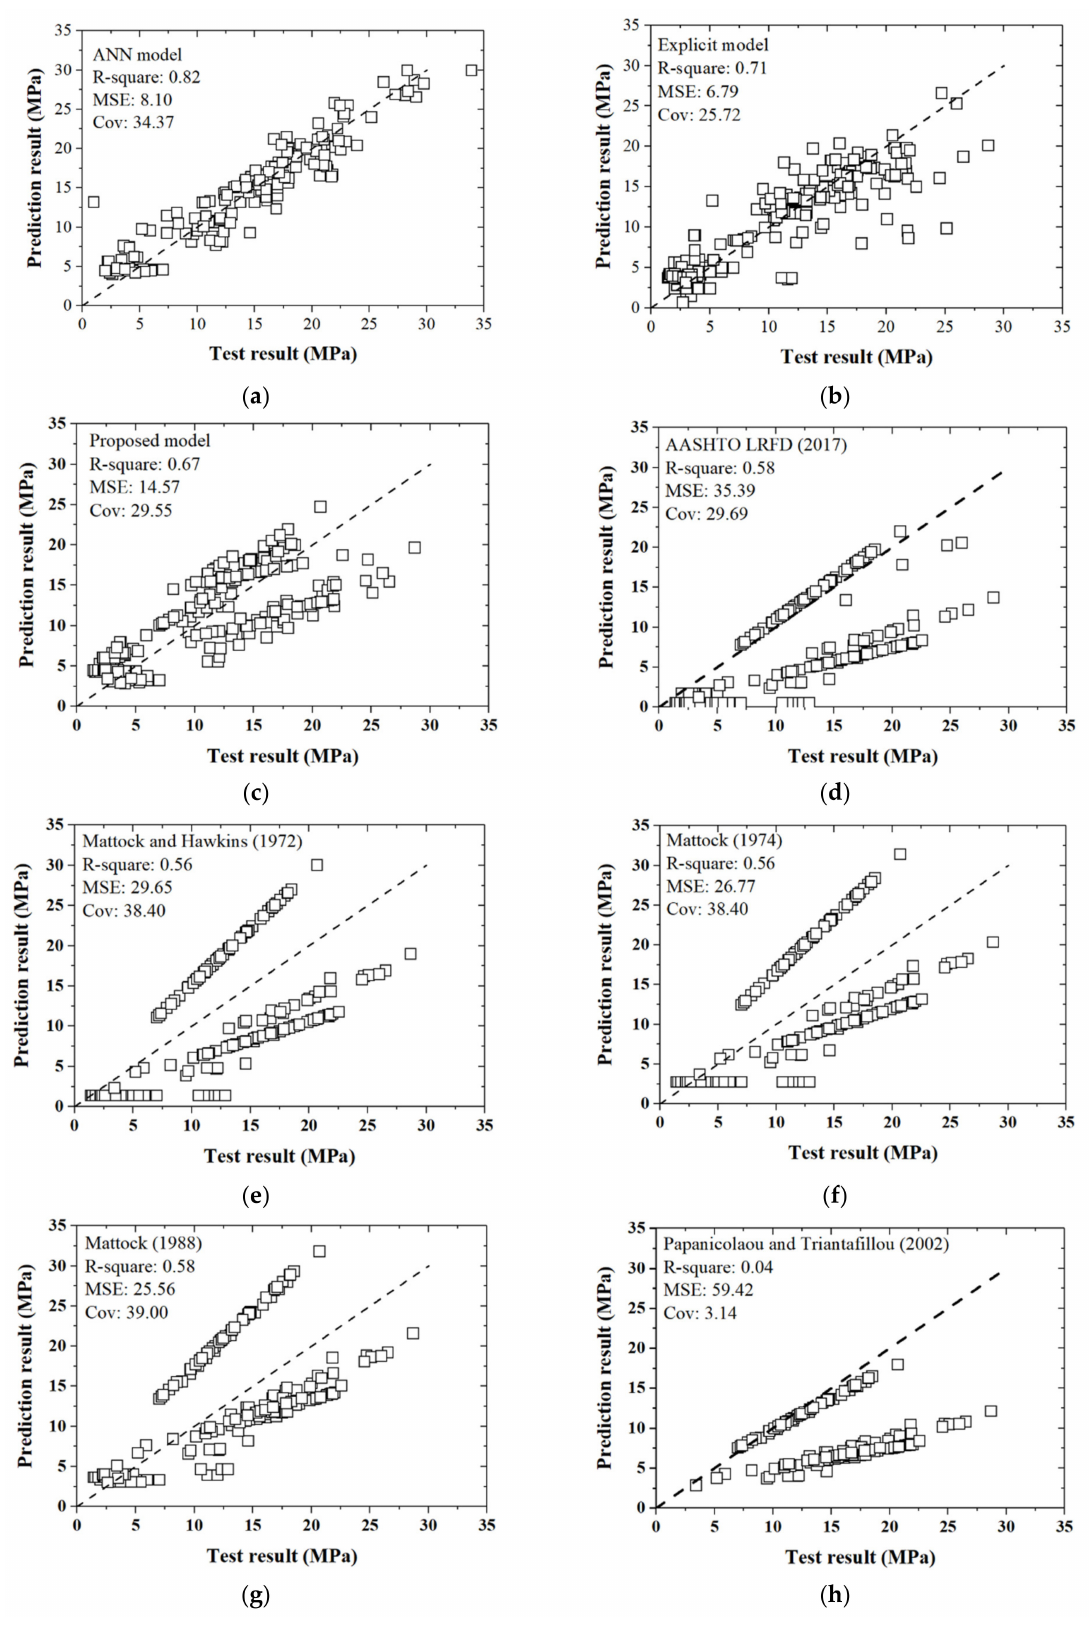
Figure 11. Comparisons of predictive accuracy of different models. ( a ) ANN model; ( b ) explicit formula; ( c ) modified shear-friction formula; ( d ) AASHTO (2017); ( e ) Mattock and Hawkins (1972); ( f ) Mattock (1974); ( g ) Mattock (1988); ( h ) Papanicolaou and Triantafillou